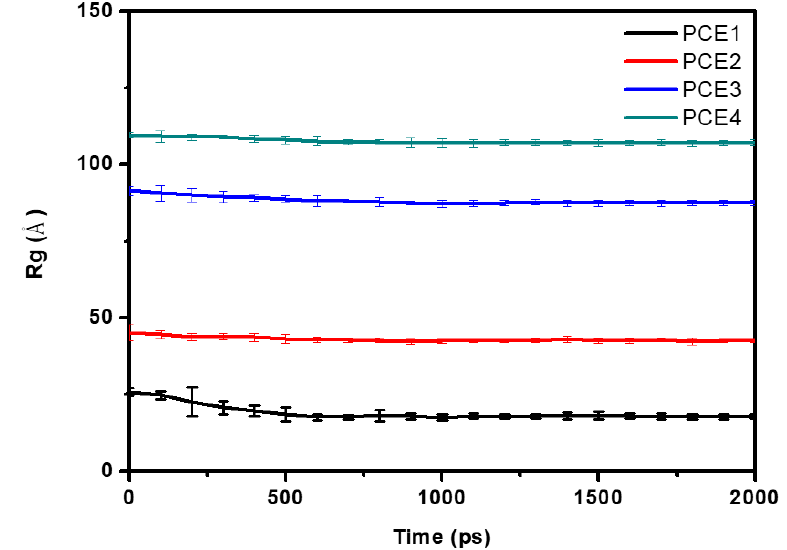
Figure 2. The radius of gyration (Rg) of PCE molecules in systems.